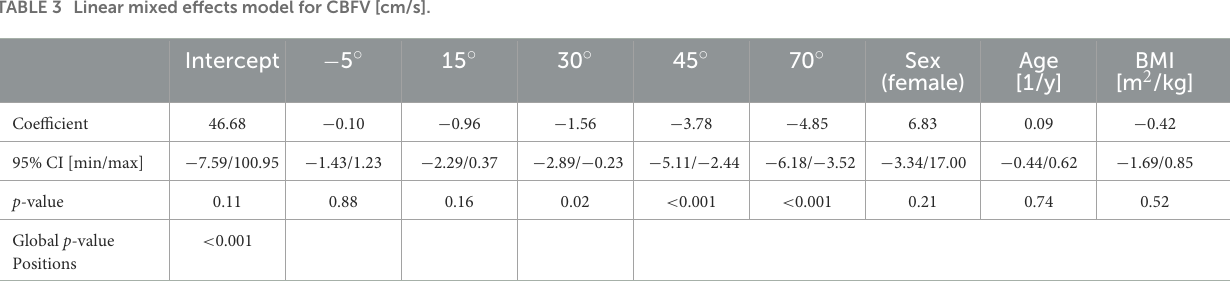
TABLE 3 Linear mixed effects model for CBFV